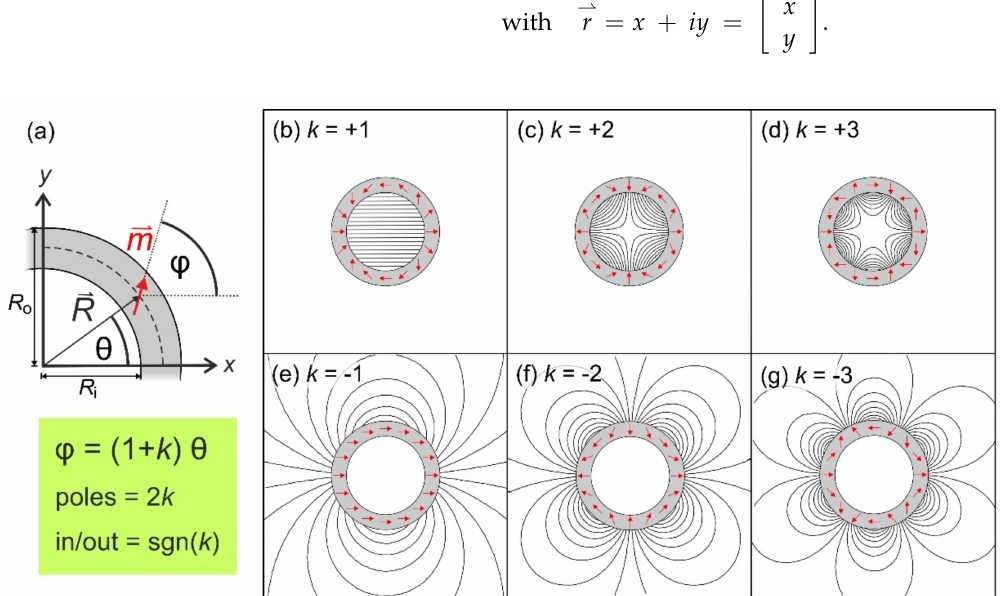
Figure A1. Conceptual idea of cylindrical ideal Halbach multipoles: ( a ) The magnet consists of a hollow cylinder of (cid:42) (cid:42) M (red arrow) is continually changing with position R (defined on permanent magnet material (gray). Its magnetization (cid:12) (cid:12) (cid:42) (cid:42) (cid:12) (cid:12) = R ). If the position makes an angle θ with the x -axis, R M is rotated by an angle ϕ . This a central circle with radius (cid:12) (cid:12) (cid:12) (cid:12) angle ϕ is an integer multiple of θ depending on the polarity and (inside/outside) location of the magnetic field of the final arrangement (Equation (A4)) as given by the index k . The polarity of such cylinders is then increased from left to right: ( b , e ) display dipolar ( | k | = 1 ) ; ( c , f ) quadrupolar ( | k | = 2 ) ; and ( d , g ) hexapolar fields ( | k | = 3 ) . The magnetic field is completely inside the cylinder for k > 0, i.e., in ( b – d ) and zero outside. The opposite is the case for k < 0. For k = 0, the magnetization has radial orientation and no transverse field (only axial, z -direction) is